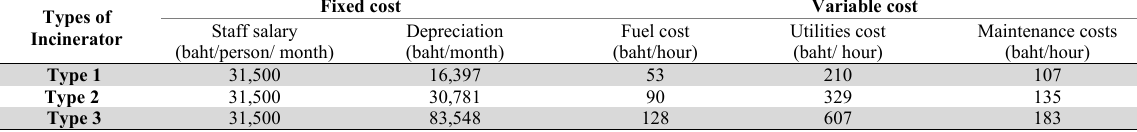
Fixed cost and variable cost of infectious waste incinerators (Sresanpila ,